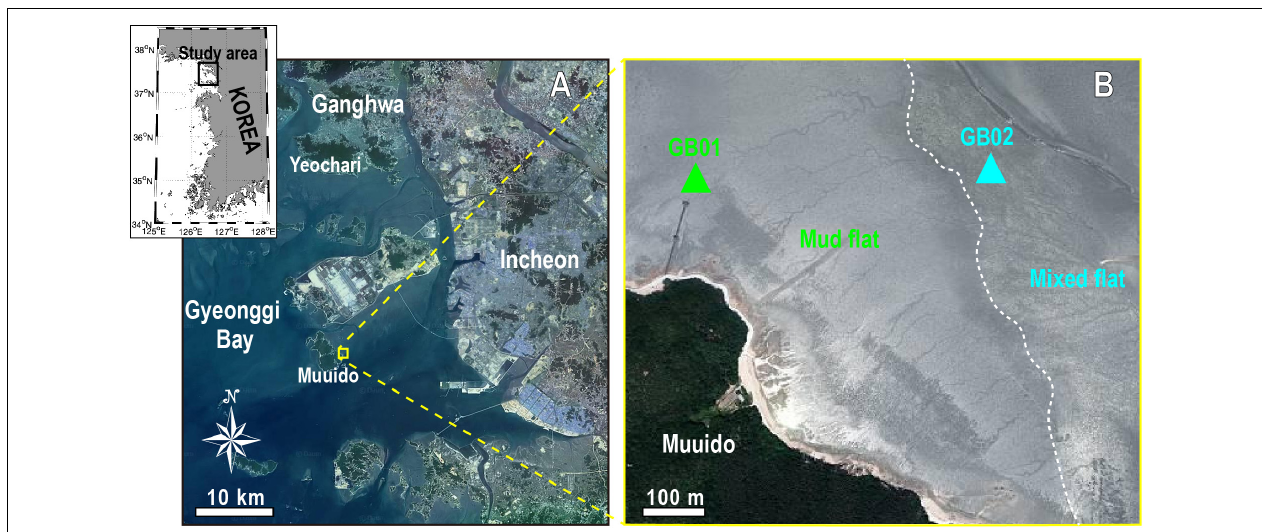
FIGURE 1 | (A) Satellite image of the Gyeonggi Bay. The upper left inset shows the coast of Korean Peninsula. (B) Study area on the Muuido tidal flat showing the two sampling sites (GB01 and GB02) for sediment cores. All satellite images were acquired from http://map.kakao.com.